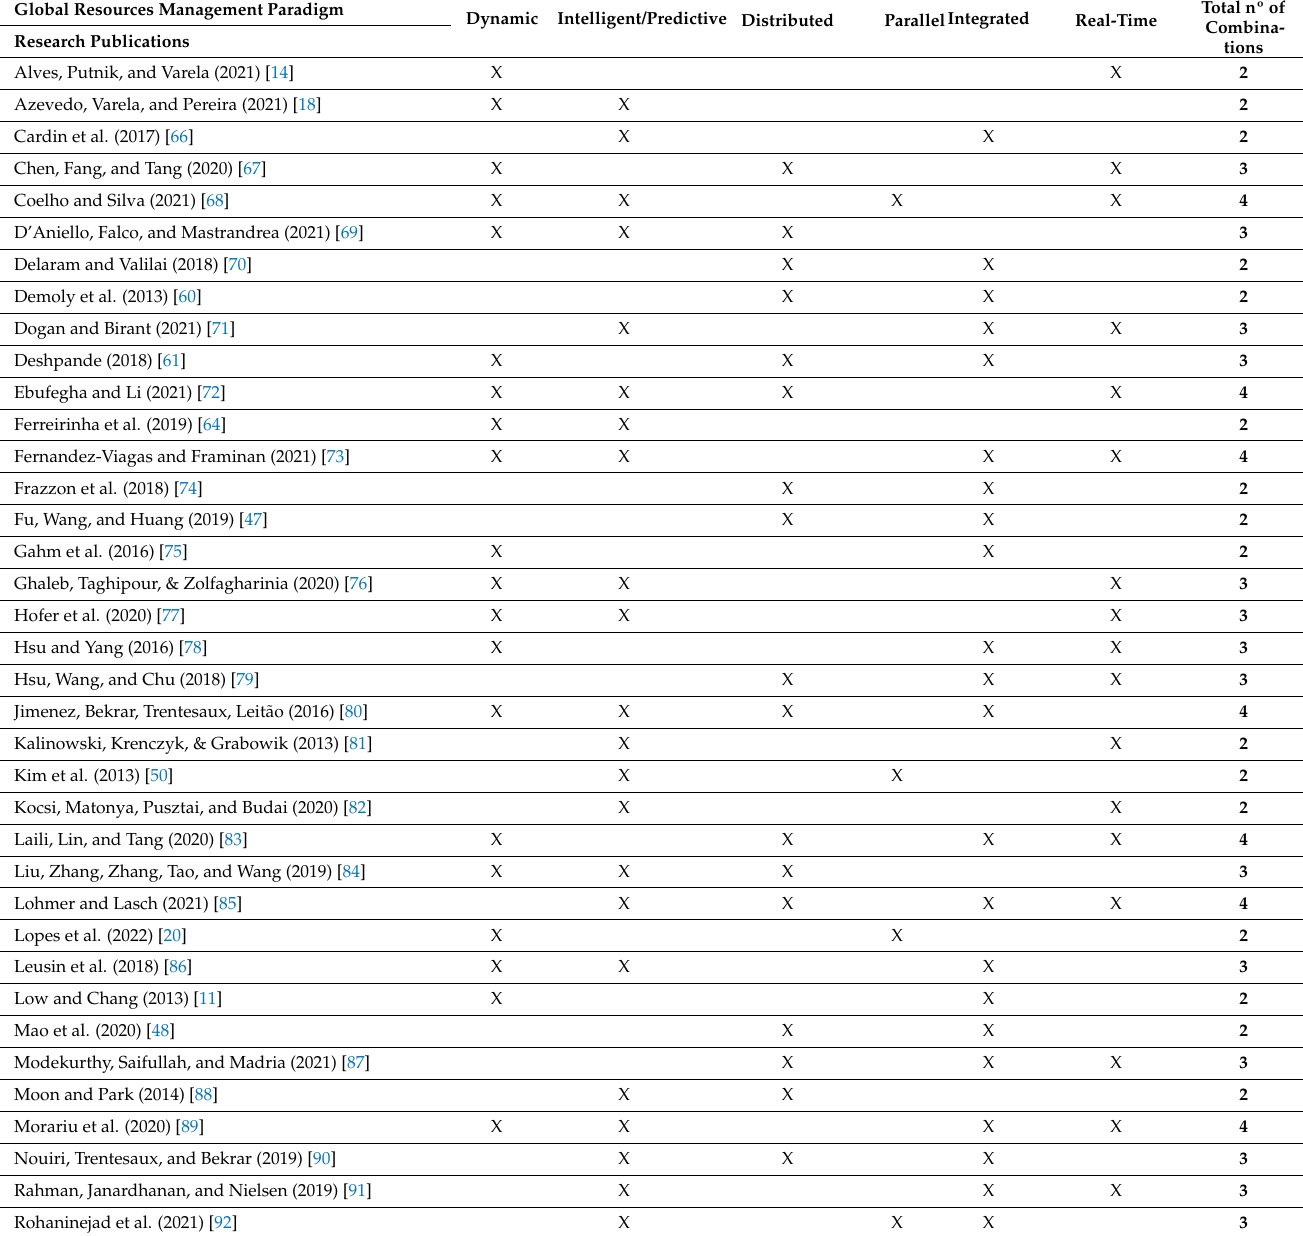
Table 2. Collaborative management paradigms used on the deeply analyzed